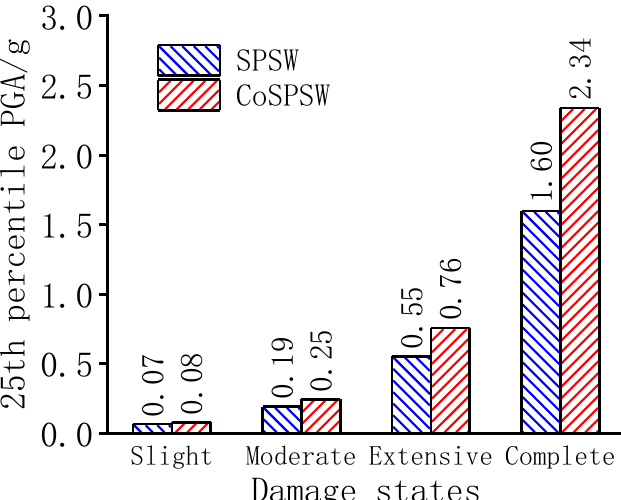
Figure 13. The 25th percentile PGA from acceleration-sensitive nonstructural fragility curves. It is clear from Figures 11–13 that from the RS1 to the RS5 repair states and from the “Slight” to the “Complete” damage states, the 25th percentile PGA values for both the CoSPSW structure and the SPSW structure increase significantly, indicating that the structures would experience more serious damages with the increase in seismic intensity.